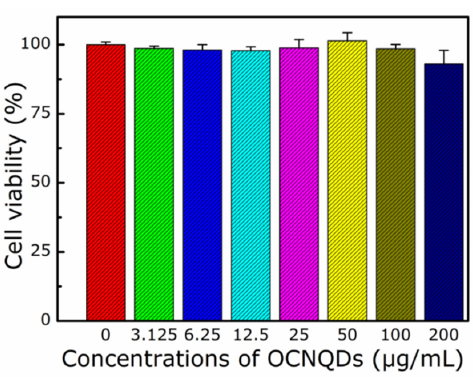
Figure 8. Cell viability of A549 cells after incubation with OCNQDs at varying concentrations of 24 h using an MTT assay.